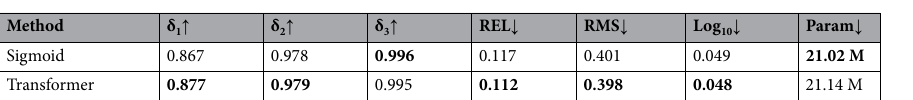
Table 7. Quantitative comparison of different fusion methods. The better results are shown in bold.